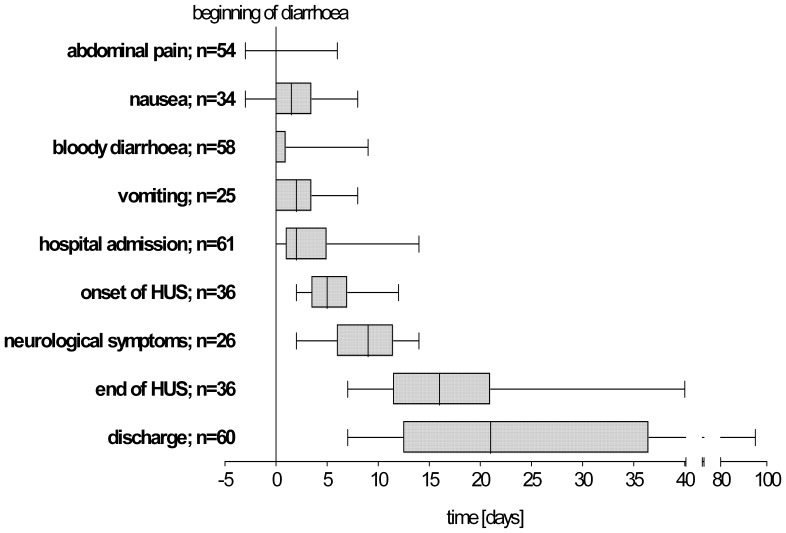
Time course of symptoms, complications, admission, and discharge in relation to the beginning of diarrhoea.[range, 25th–75th -percentile, median].